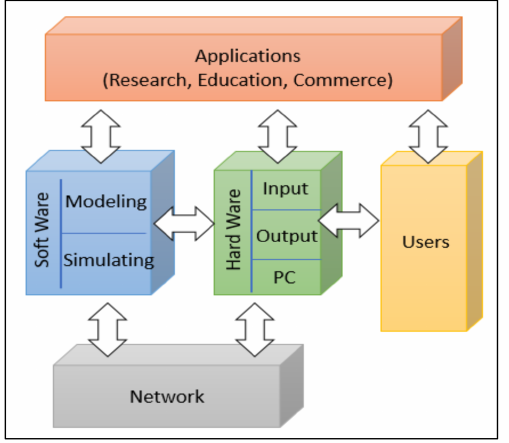
Figure 1. Components of a VR